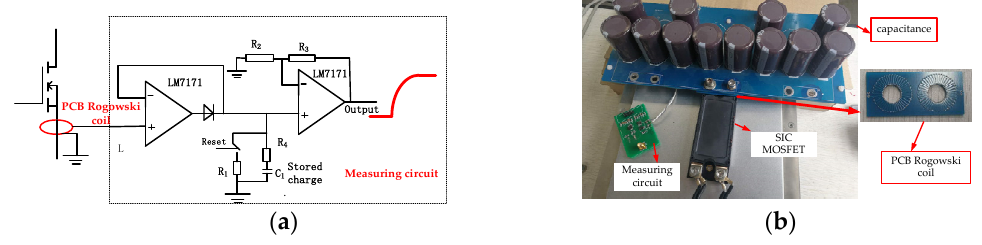
Figure 16. ( a ) dI DS /dt measuring circuit based on printed circuit board (PCB) Rogowski coil; ( b ) measurement circuit appearance.